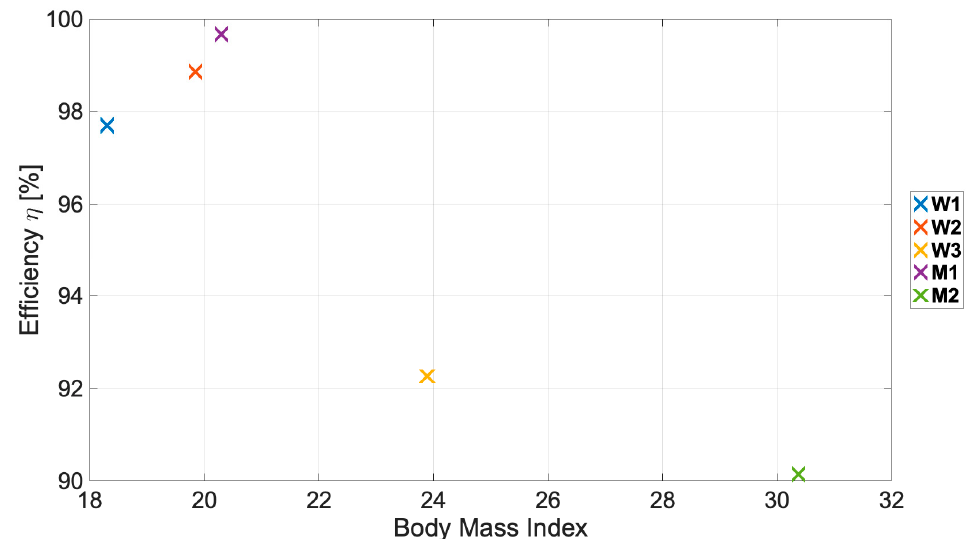
Figure 3. DFNN effectiveness η as a function of the Body Mass Index (BMI) parameter for the one- Figure 3. DFNN e ff ectiveness η as a function of the Body Mass Index (BMI) parameter for the one-person person training set. training set.